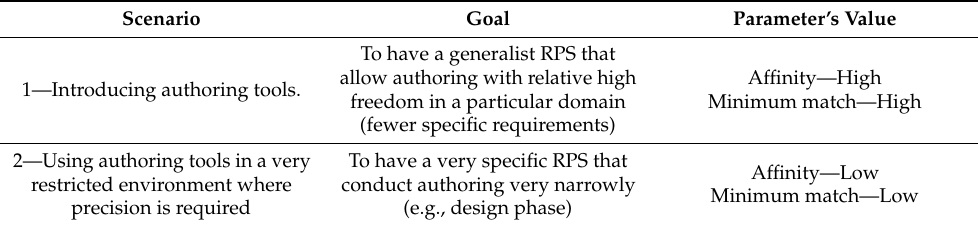
Table 11. Scenarios for using the methodology in future